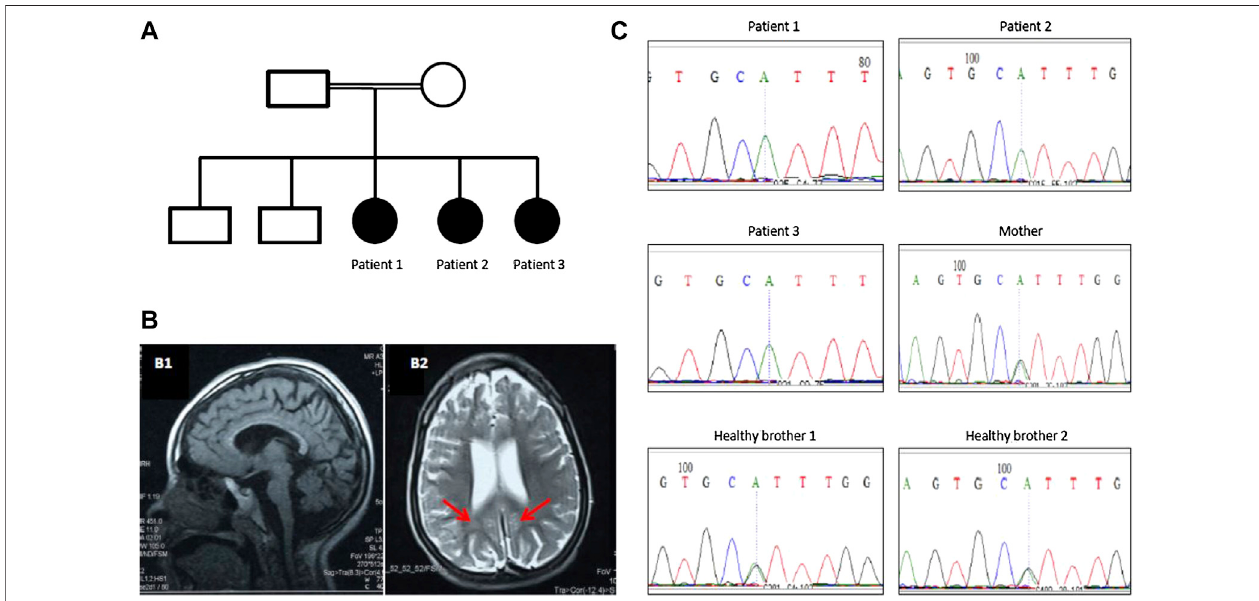
FIGURE1|(A) FamilypedigreeofaSudanesefamilywithPCH10. (B) BrainMRIofpatient1showingmildpontineandcerebellaratrophyandthincorpuscallosum (B1)andperiventricularwhitematterchanges(redarrowsinB2). (C) SegregationofCLP1(c.419G > A;p.Arg140His)pathogenicvariantinthefamilywithpontocerebellar hypoplasia